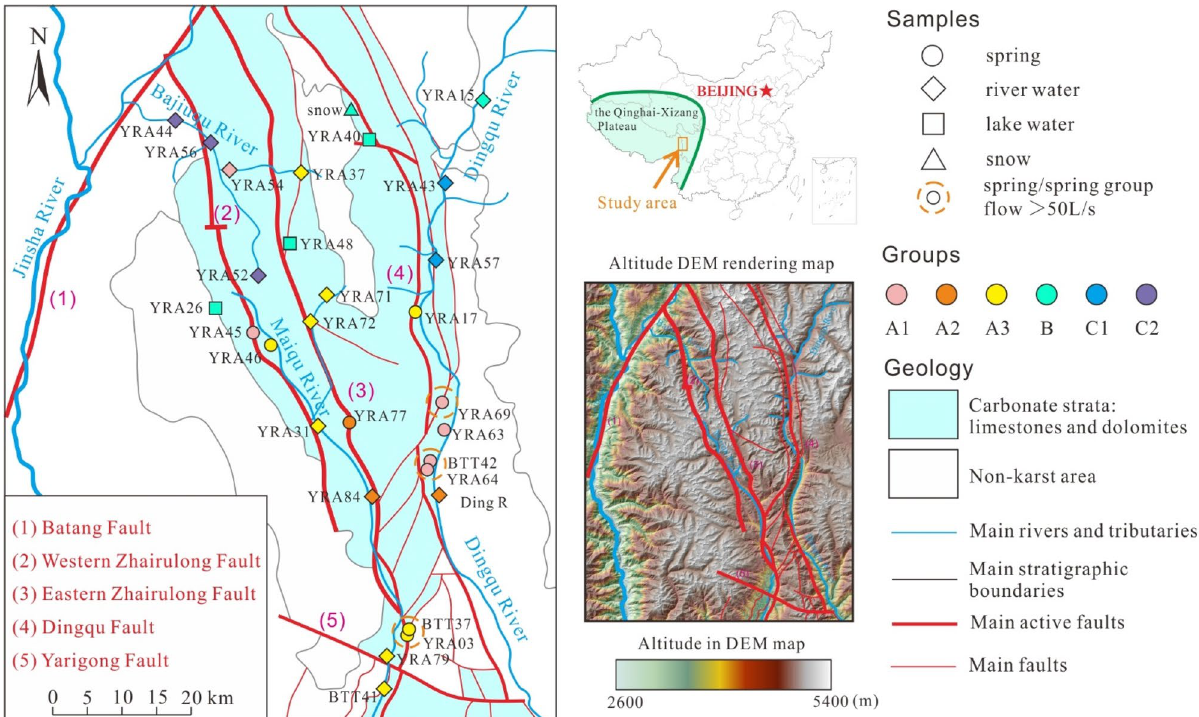
Figure 1. Hydrogeological map of the study area, including sampling locations. The faults, rivers, and area of carbonate rock distribution are from the China Geological Survey (https:// www. cgs. gov. cn/), a digital elevation model rendering map background derived from the Spatial Data Cloud (http:// www. gsclo ud. cn/) and generated using ArcGIS v 10.0, and a location map of the study area obtained from the Ministry of Natural Resources, People’s Republic of China (https:// www. mnr. gov. cn/). The figure was generated using CorelDRAW